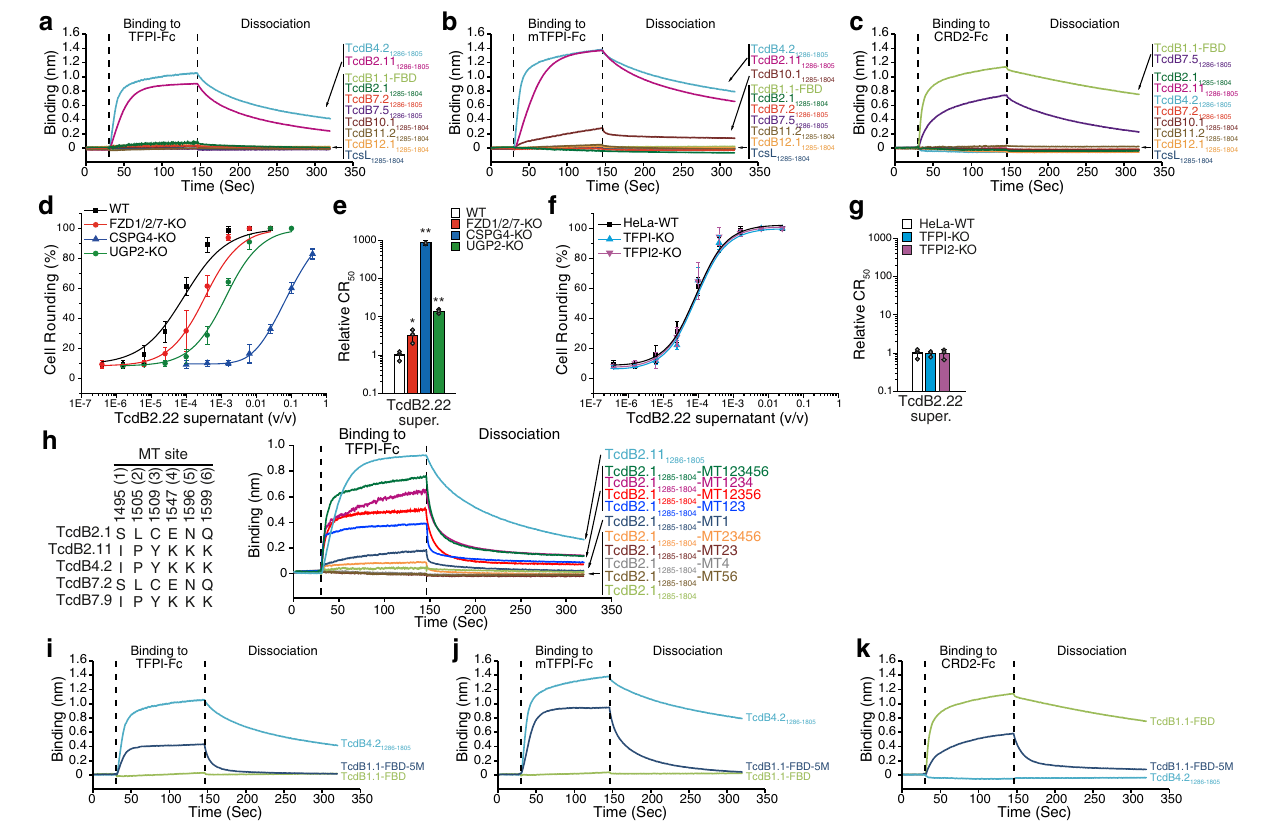
Fig. 6 | IR generates receptor-switching in TcdB. Binding of 500nM TcdB1.1- FBD, TcdB2.1 are shown. d , e HeLa-WT, FZD1/2/7-KO, CSPG4-KO, and UGP2-KO cells were exposed to the culture supernatant of a C. dif fi cile strain expressing TcdB2.22 for 24h.Thepercentagesofround-shapedcellswereplottedoversupernatantdilution ( d ). The relative CR 50 values in different cell lines were normalized to the WT and plotted as a bar-chart ( e ). Error bars indicate mean±s.d.; N =3 (biologically inde- pendentexperiments);*, p <0.05;**, p <0.01(Student ’ s t -test,two-sided). f , g HeLa- WT, TFPI-KO, and TFPI2-KO cells were exposed to the culture supernatant of a C. dif fi cile strainexpressingTcdB2.22for24h.Thepercentagesofround-shaped cells were plotted over supernatant dilutions ( f ). The relative CR50 values in different